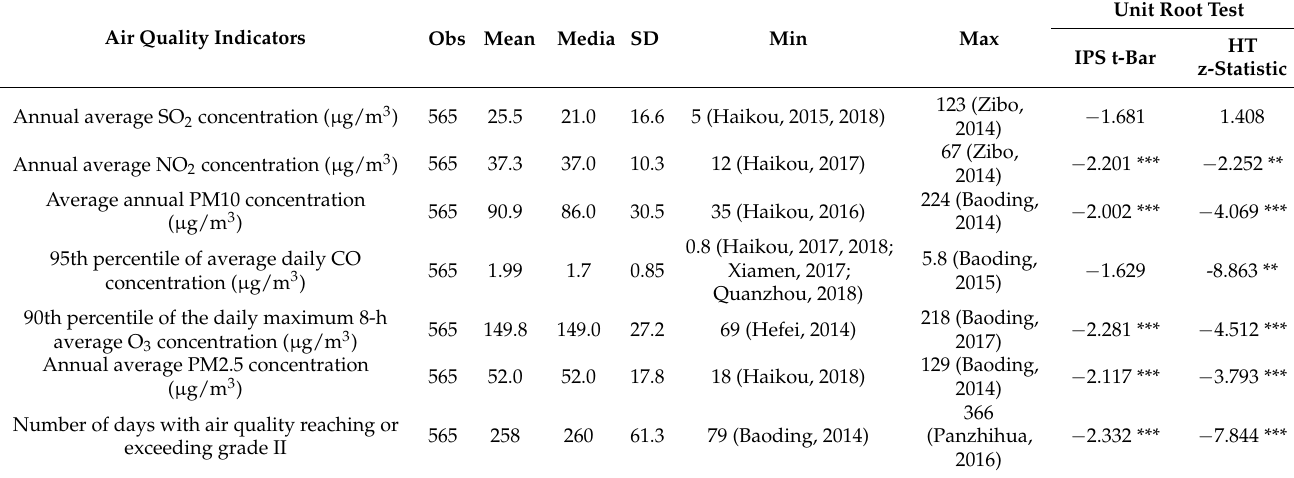
Note: Obs indicates the number of observations. SD indicates standard deviation. Min indicates minimum value. Max indicates maximum value. IPS indicates Im, Pesaran and Shin (2003). HT indicates Harris and Tzavalis (1999). Superscripts, **, and *** indicate significant levels of confidence at 5%, and 1%,